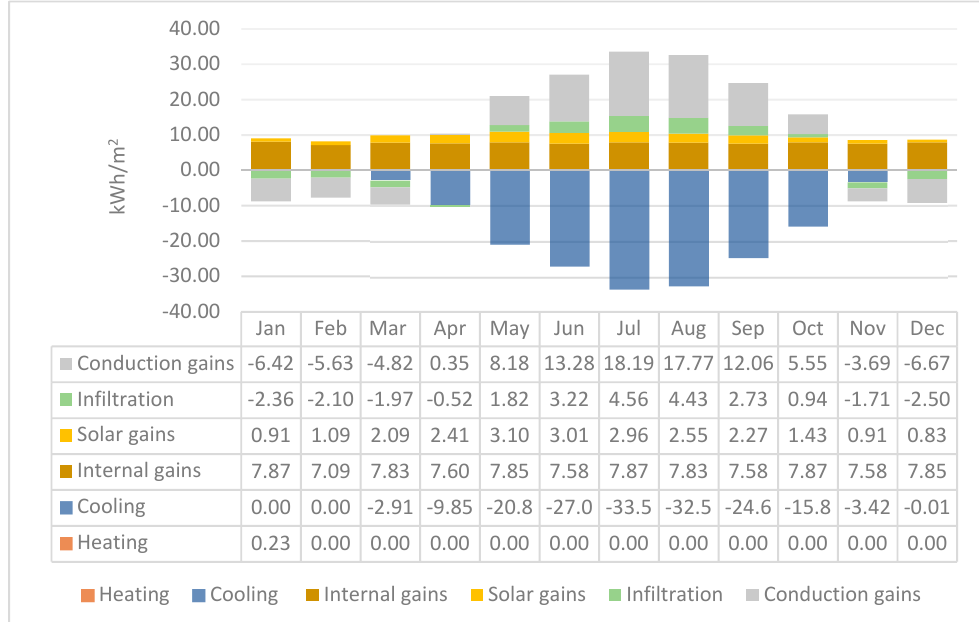
The scores of all the alternatives were calculated, and the rankings were established. The scores for both scenarios are reported in Tables 5–8. Table 5. The scores for all opaque alternatives in the overall normalized scenario. Cairo